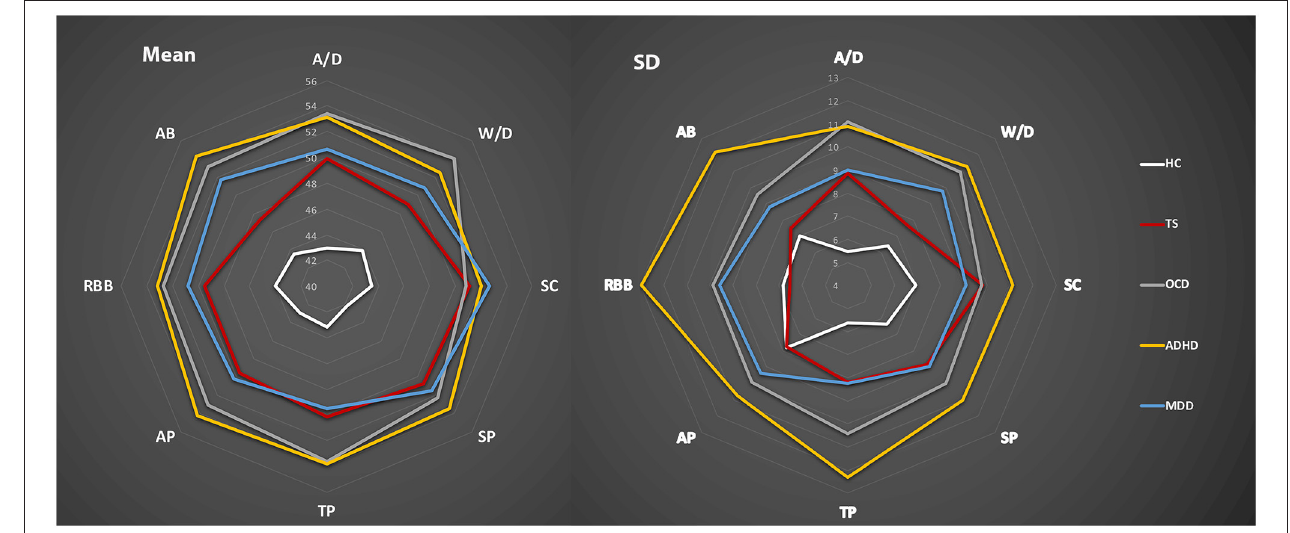
FIGURE 3 | The CBCL profile of the TS and other compared